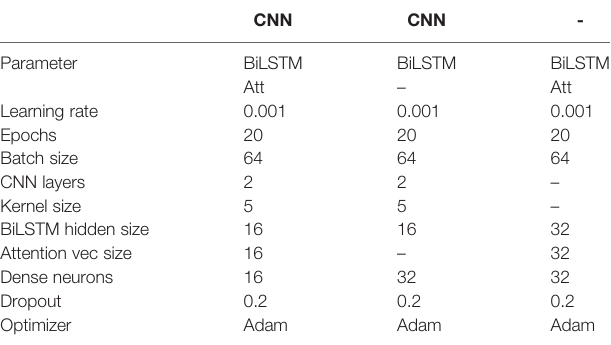
TABLE 2 | Parameters setting of different models.